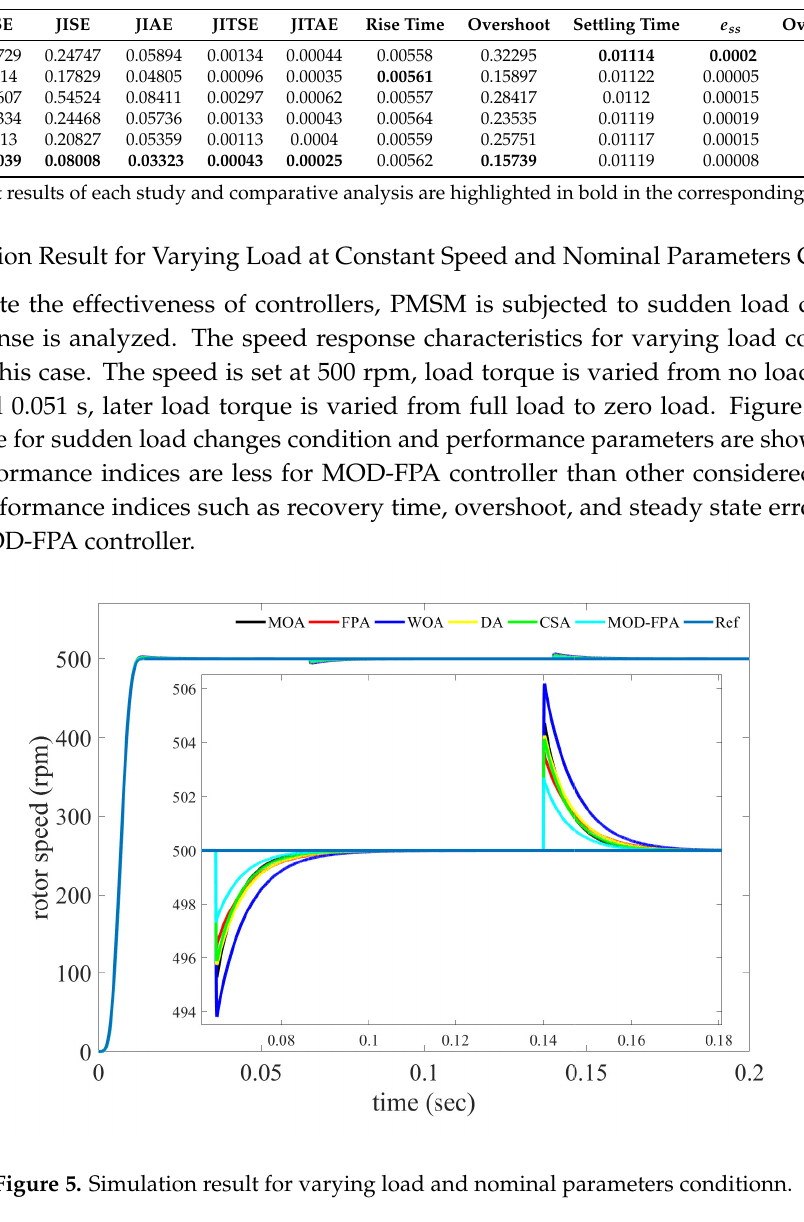
Table 6. Performance analysis for speed tracking task with constant load and nominal parameters condition.